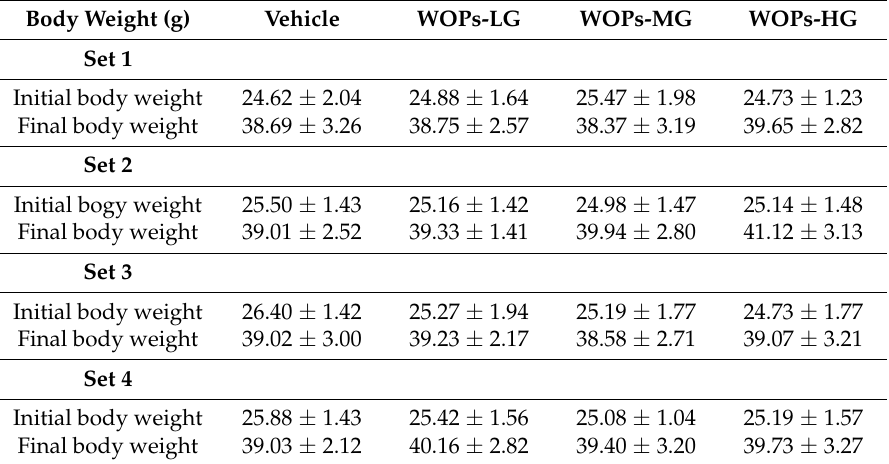
Table 1. Effects of WOPs on the body weight in mice. Table 1. Cont.